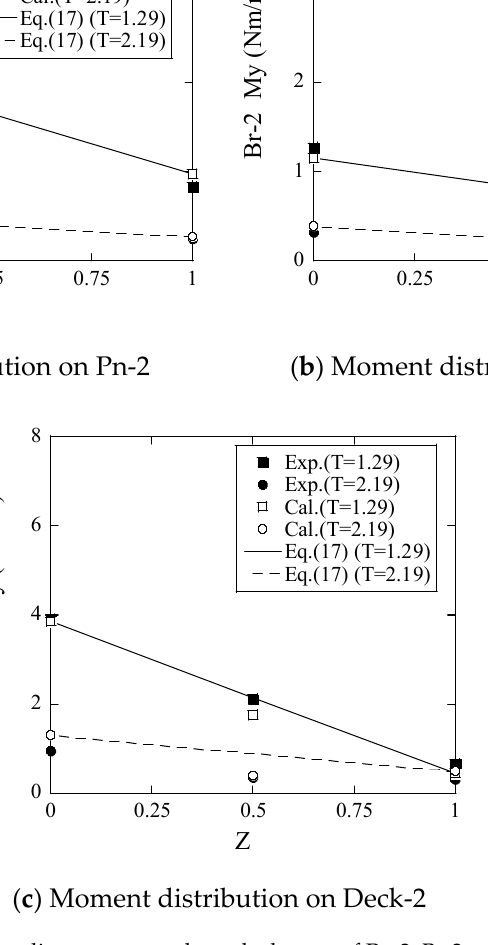
Figure 12. Distribution of bending moments along the beams of Pn-2, Br-2 and Deck-2 ( H = 0.05 m).